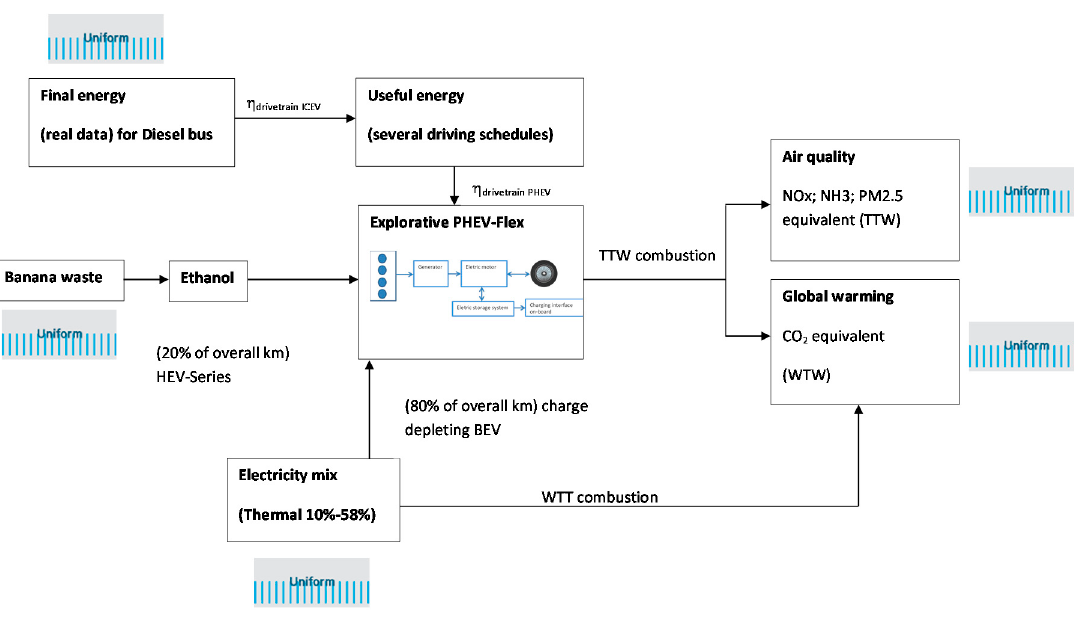
Figure 1. Simplified model scheme for air quality indicators tank-to-wheels (TTW) and global warming impact well-to-wheels (WTW) evaluation/graphical abstract.